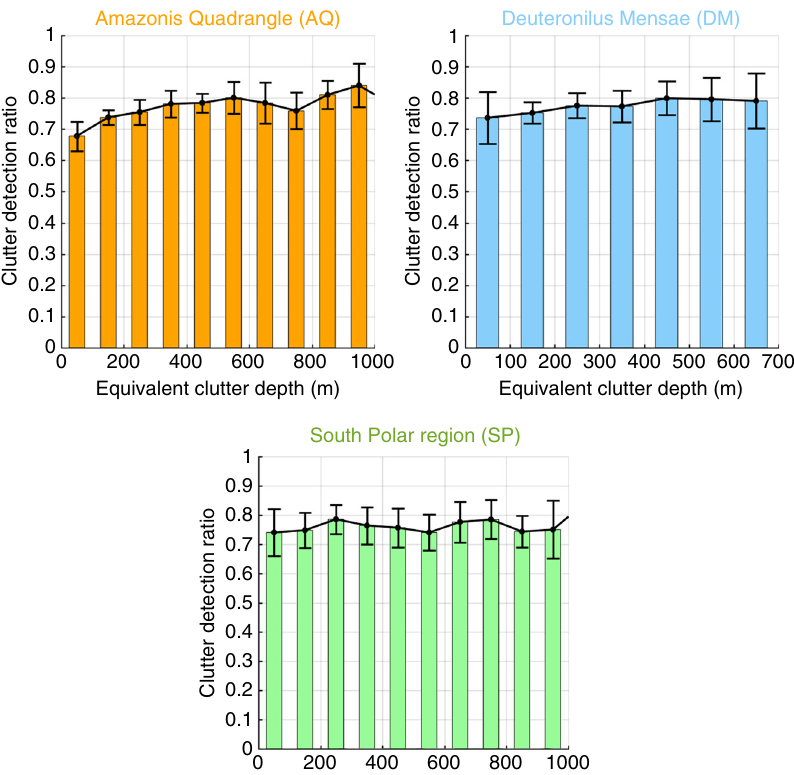
Fig. 6 Clutter detection results. Clutter detection ratio that is de fi ned as the number of clutter feature correctly classi fi ed as clutter over the total number of clutter features detected at each given depth, and related mean absolute deviation versus the equivalent penetration depth for the different data sets. The statistics were computed considering the SHARAD tracks displayed in Supplementary Fig. 4. The maximum equivalent clutter depth depends on the surface roughness. The rougher the surface the higher the measured maximum equivalent clutter depth for a given data